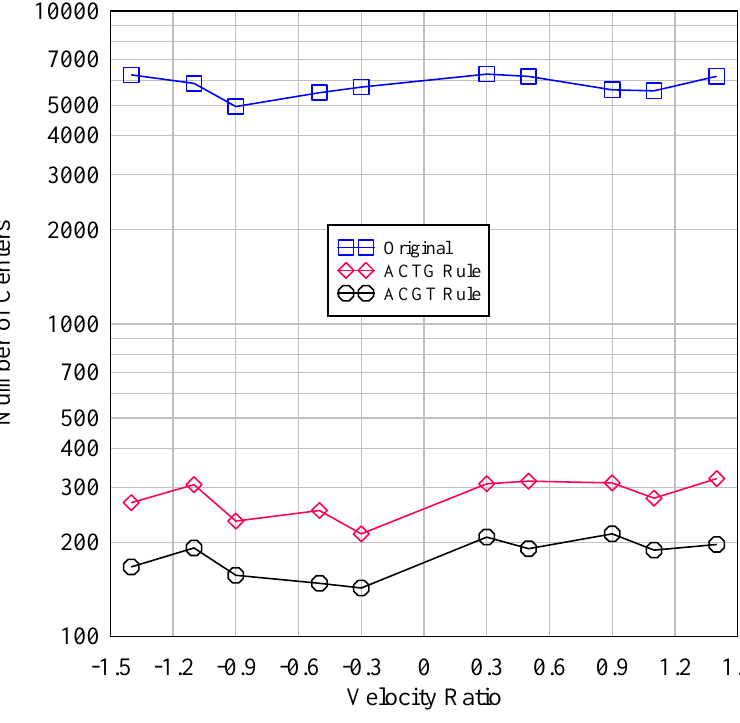
Figure 11. Noise reduction capacity of DBC.